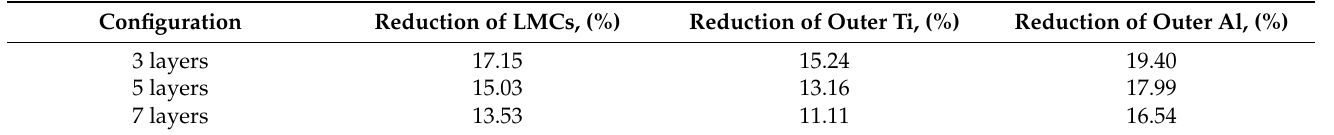
Table 2. The thickness-thinning ratio of the deep-drawing parts of LMCs with different layers at the corner section. Configuration